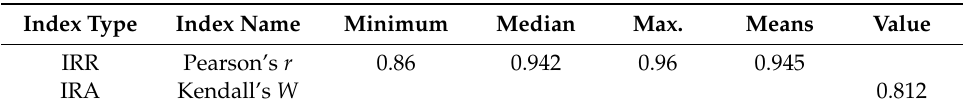
The indices of intra-rater reliability (IRR) and intra-rater agreement (IRA) for our similarity